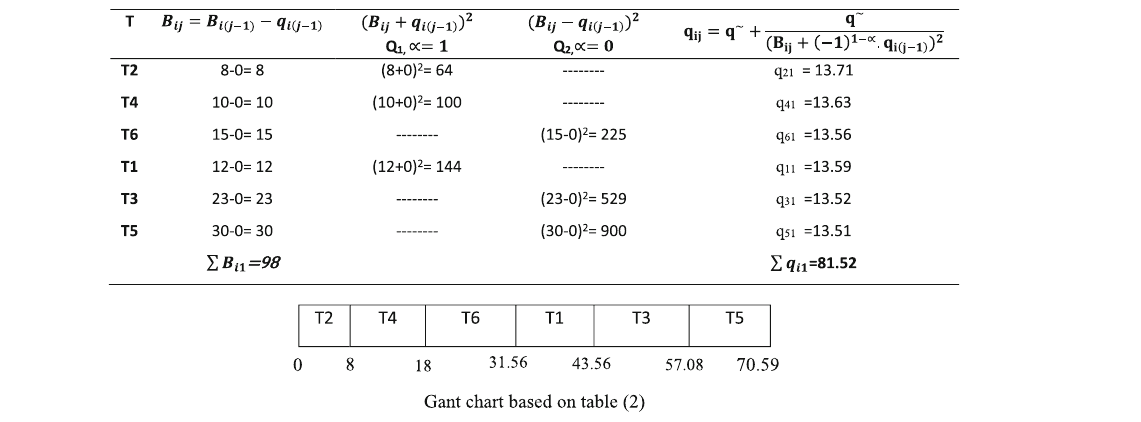
Table 2 Task quantum calculations in first